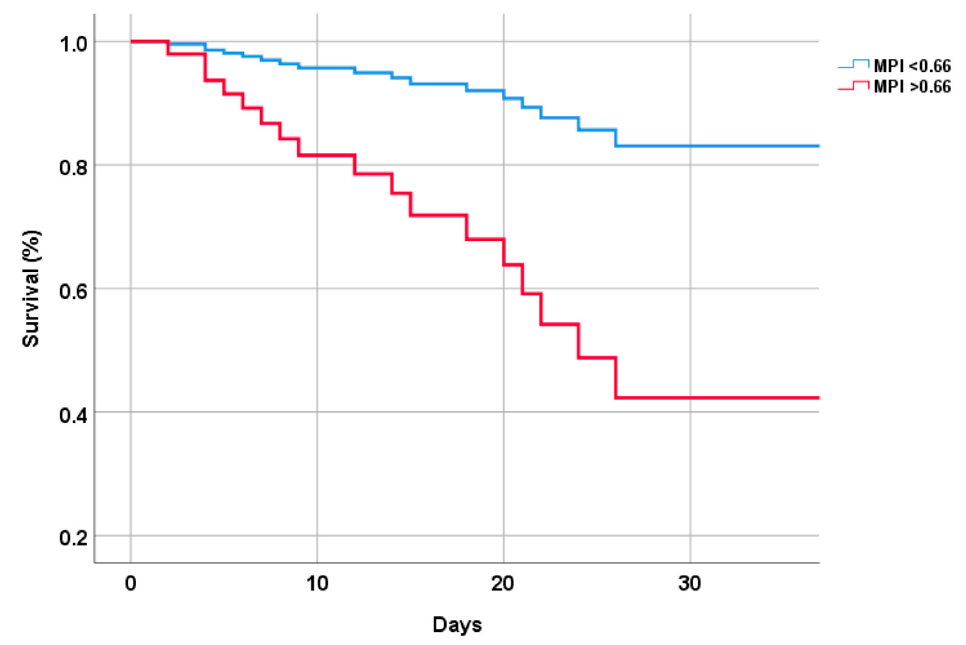
Figure 1. Survival curve by multidimensional prognostic index values.